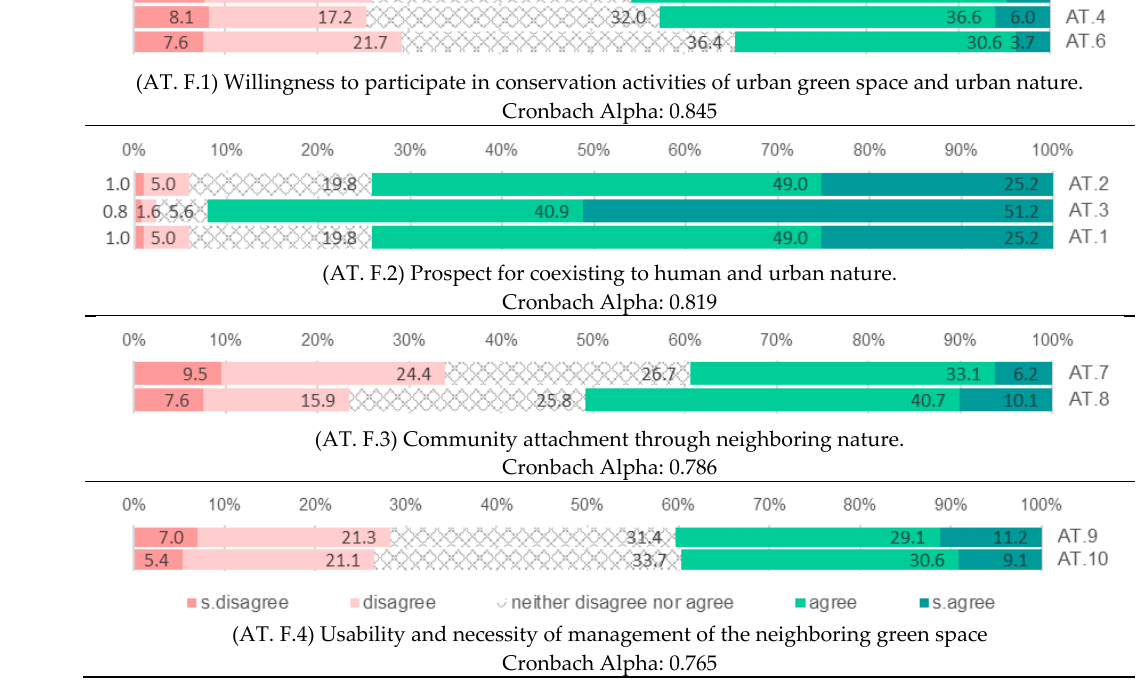
Figure 9. Residents’ attitude to UGS and urban nature. (AT.1) I cherish the urban nature with plants and animals; (AT.2) UGS makes my everyday life environment healthy; (AT.3) it is important to coexist with plants, animals, and humans in an urban environment; (AT.4) I’m willing to participate as a volunteer to conserve nature (AT.5) I’m willing to arrange a time for conserving nature; (AT.6) I’m willing to pay some money to conserve nature; (AT.7) I’ve known plants, animals, and insects that are often observed in or near my area; (AT.8) I can feel the community attachment from plants, animals, and insects that are often observed in or near my area; (AT.9) the neighborhood green space should be managed; and (AT.10) the neighborhood green space should be convenient.